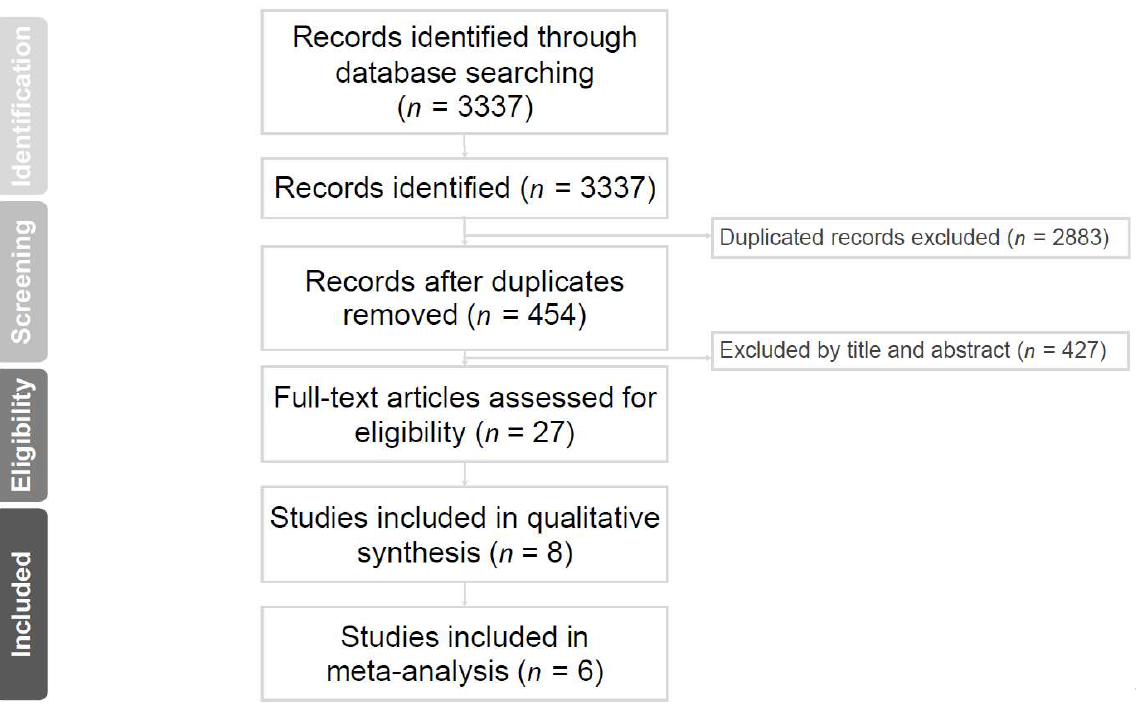
Figure 1. Flow diagram for study selection.